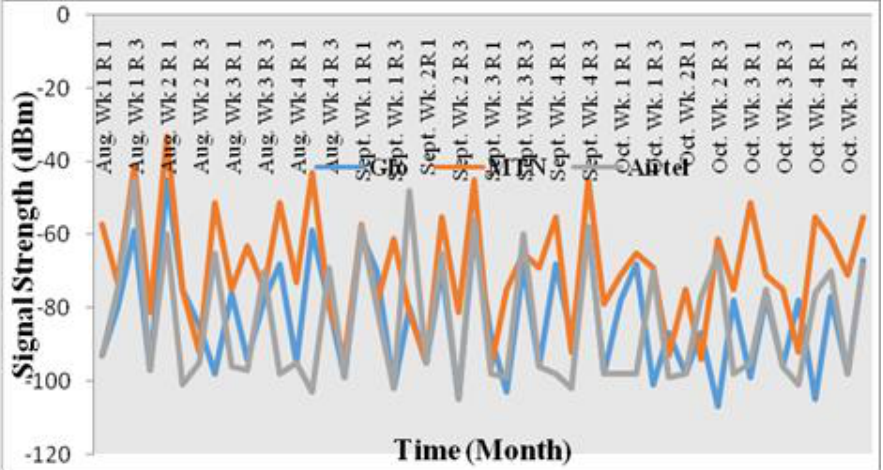
Figure 4: Graphical Representation of Received Signal Strength of Glo, MTN andAirtel at EACOED,